Question: Is the quantity shown trending increasing or decreasing?
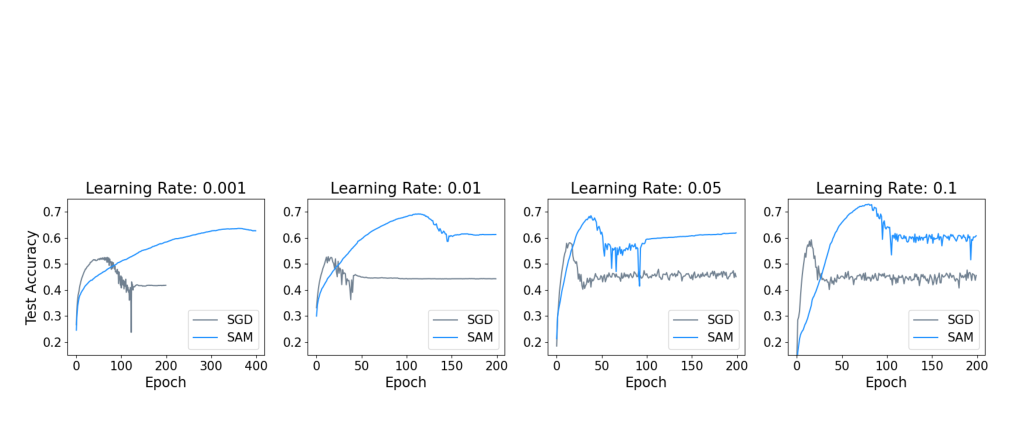
Answer: increasing